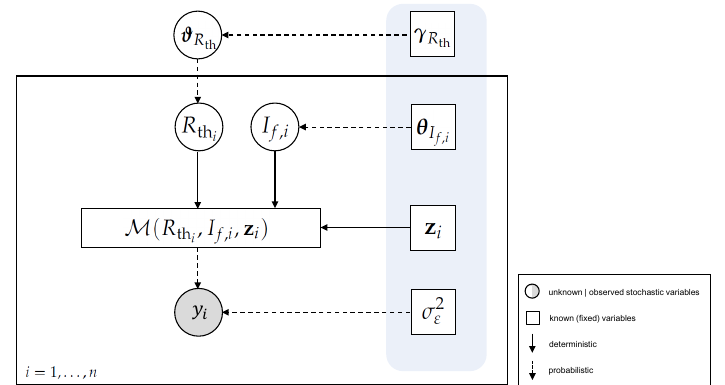
Figure 4. Representation of the BHM in (11) as a directed acyclic graph